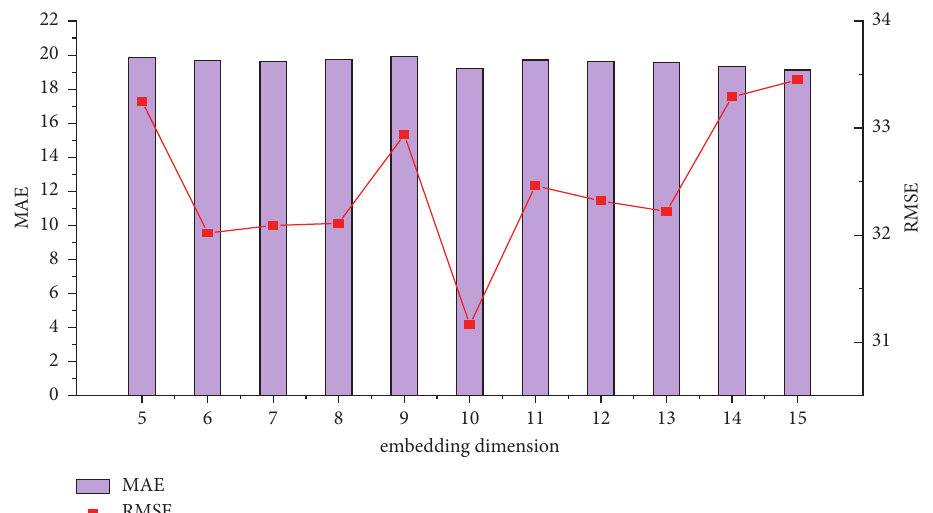
Figure 12: The effect of embedding dimension on the prediction performance.